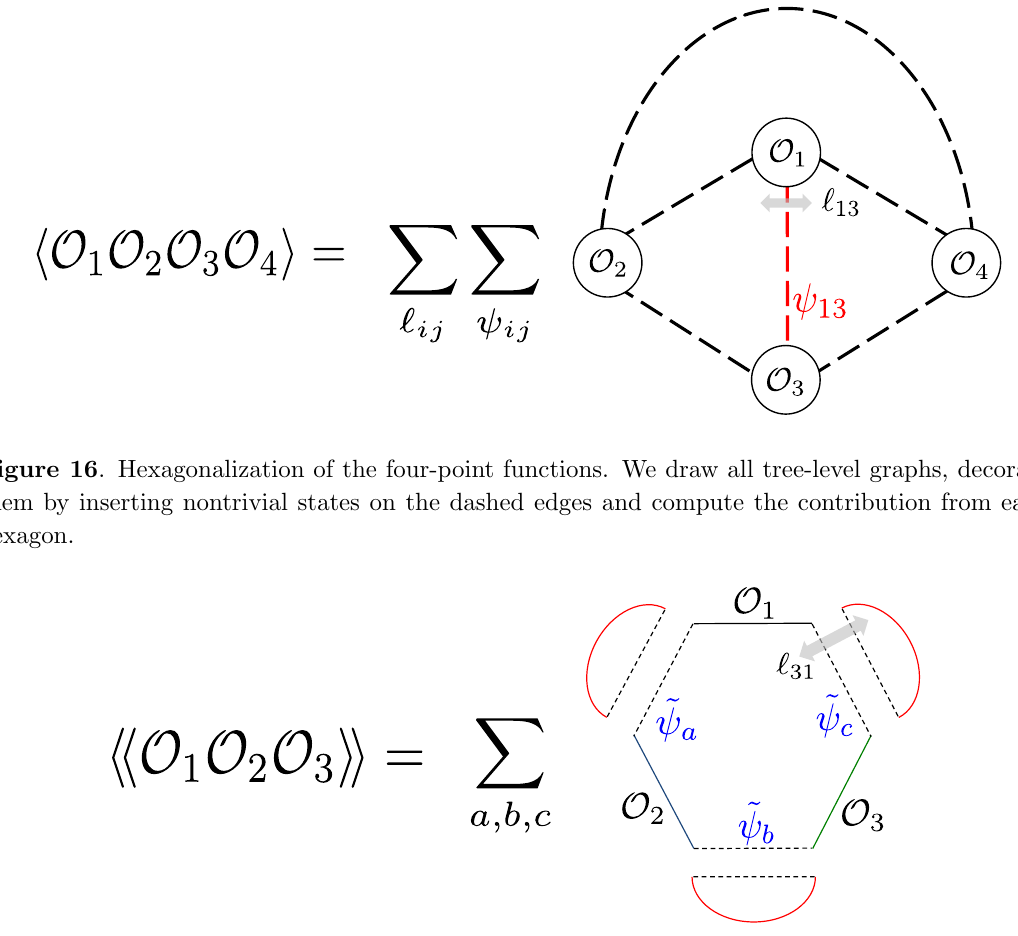
Figure 17 . Hexagonalization of the three-point function on the Wilson loop. The red curves denote the boundary states. We glue the boundary states to the hexagon by summing over all the intermediate states that appear in the expansion of the boundary state